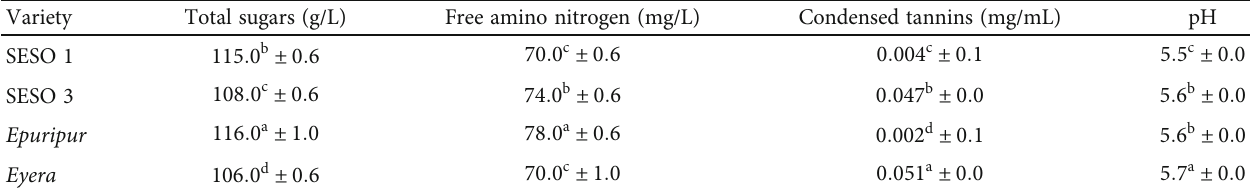
Table 3: Composition and physicochemical properties of sorghum malt